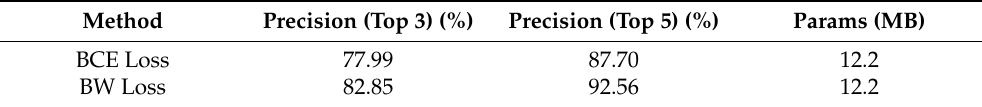
Figure 7. Results with BW loss compared to BCE loss. ( a ) is an example of cloud amount calculation result of remote sensing image of speckled cloud. ( b ) is an example of cloud amount calculation results of thin cloud remote sensing image. ( c ) is an example of cloud amount calculation result of remote sensing image of thin cloud and thick cloud mixture. ( d ) is an example of cloud amount calculation results of remote sensing images of thin clouds and speckled clouds. Table 5. Effects of different loss functions on the CTI_RSCloud